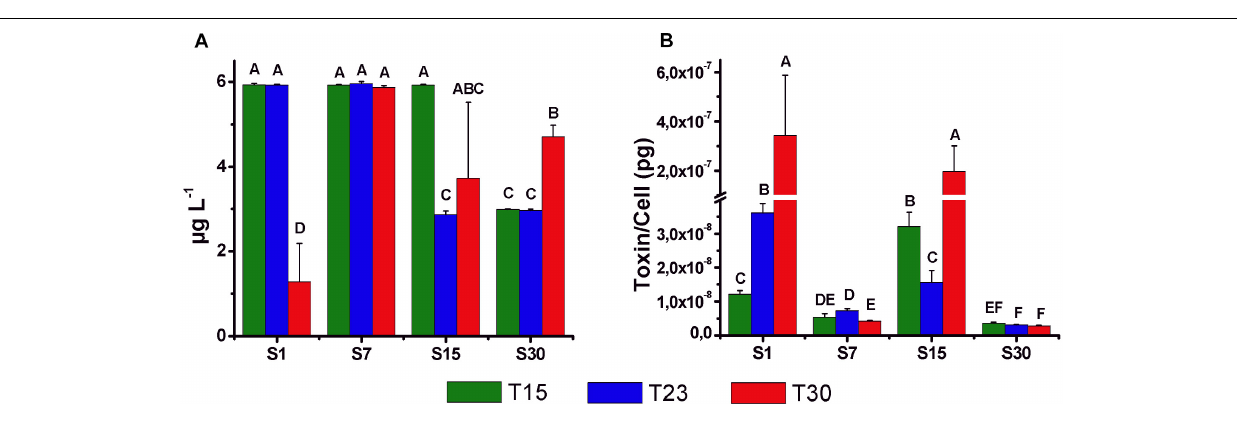
FIGURE 8 | Mean concentration ( ± SD; n = 3) of intracellular nodularin ( µ g l − 1 ) (A) and toxin content per cell (pg cell − 1 ) (B) at the beginning of the stationary phase of the growth curves for different treatments. Significant differences are indicated by letters (ANOVA, Tukey’s p <